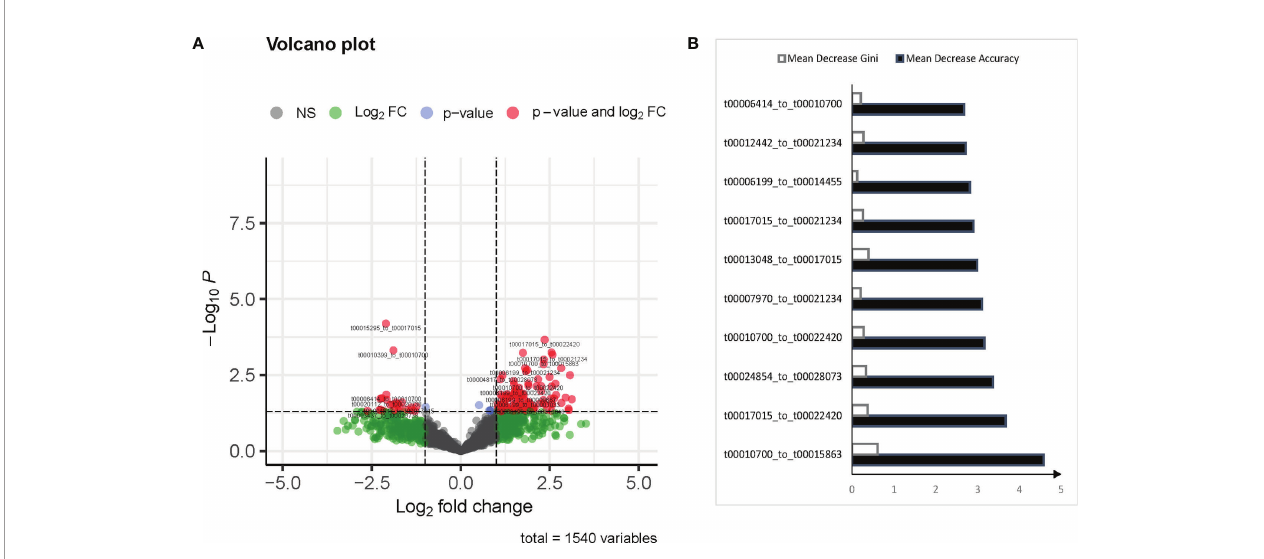
FIGURE 1 | mtRNA diagnostic panel. (A) Volcano plot of differentially expressed mtRNAs between normal and pulmonary tuberculosis (TB). (B) Mean Decrease Accuracy shows the relative degree to which a factor improves the accuracy of the forest in classi fi cation prediction; Mean Decrease Gini assigns a weight of importance to each parameter, which improves accuracy of the